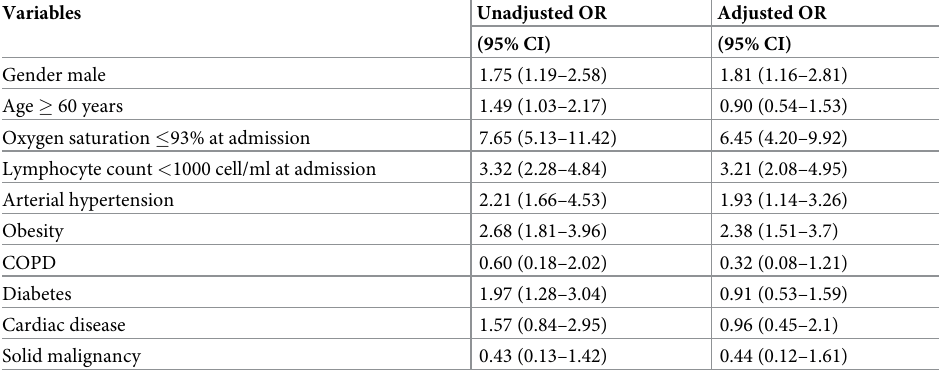
Table 5. Multivariable analysis of characteristics associated with intensive care unit admission among 809 patients with COVID -19 in Argentina.